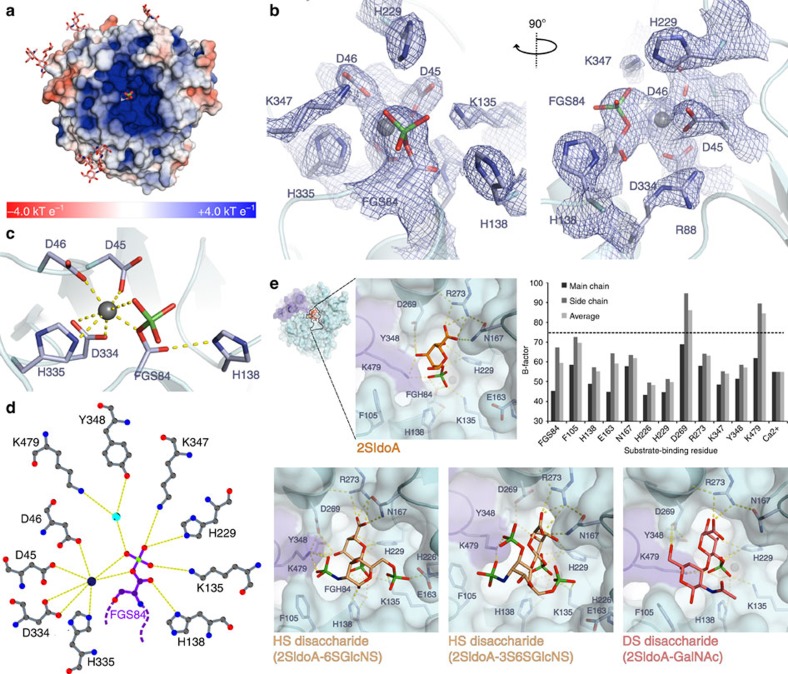
Details of IDS active site and substrate-binding cleft.(a) The substrate-binding cleft is coloured by electrostatic potential at the solvent-accessible surface from red (negative, −4.0 kT e−1) to blue (positive, +4.0 kT e−1). Electrostatic potential was calculated using a pH value of 4.8 when assigning side chain protonation. The catalytic, modified FGS84 residue is shown as sticks. (b) Two orthogonal views of electron density (blue mesh, 2mFO−DFC, contoured at 0.35 e− Å−3) for IDS active-site residues (grey sticks) and the Ca2+ ion (grey sphere). (c) Details of the Ca2+ ion coordination (yellow dashed lines) in the IDS active site. (d) Schematic representation of amino acid side chain interactions with the covalently-modified FGS84 residue. Hydrogen bonds (yellow dashed lines) are shown. (e) Docked structures of 2-sulfo-iduronic acid, two variably sulfated heparan sulfate disaccharides and a dermatan sulfate disaccharide, showing details of the putative substrate-binding region. Hydrogen bonds (dashed yellow lines) are indicated. For solvent-accessible residues situated in the substrate-binding cleft, a graph of average B-factor per residue is shown. The mean B-factor for all IDS non-hydrogen atoms is indicated with a dotted line.